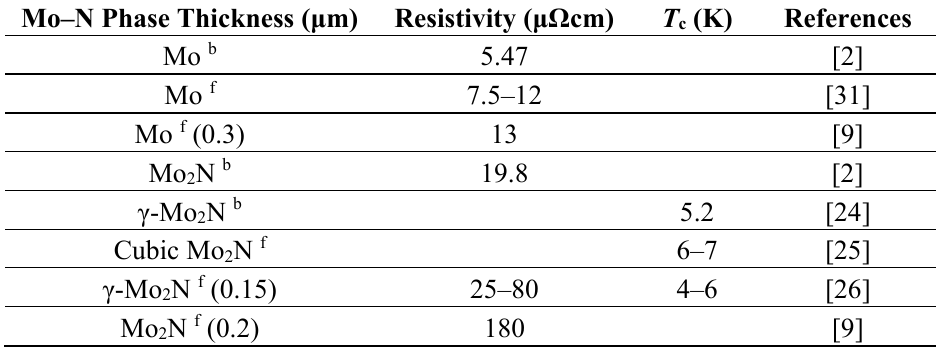
Table 4. Resistivity and superconducting temperature of Mo 2 N and MoN films ( f ) compared with bulk values ( b ), theoretical values ( th ), Mo, and C (diamond). The amorphous structures are indicated with (a). The thickness of films (if known) is indicated in